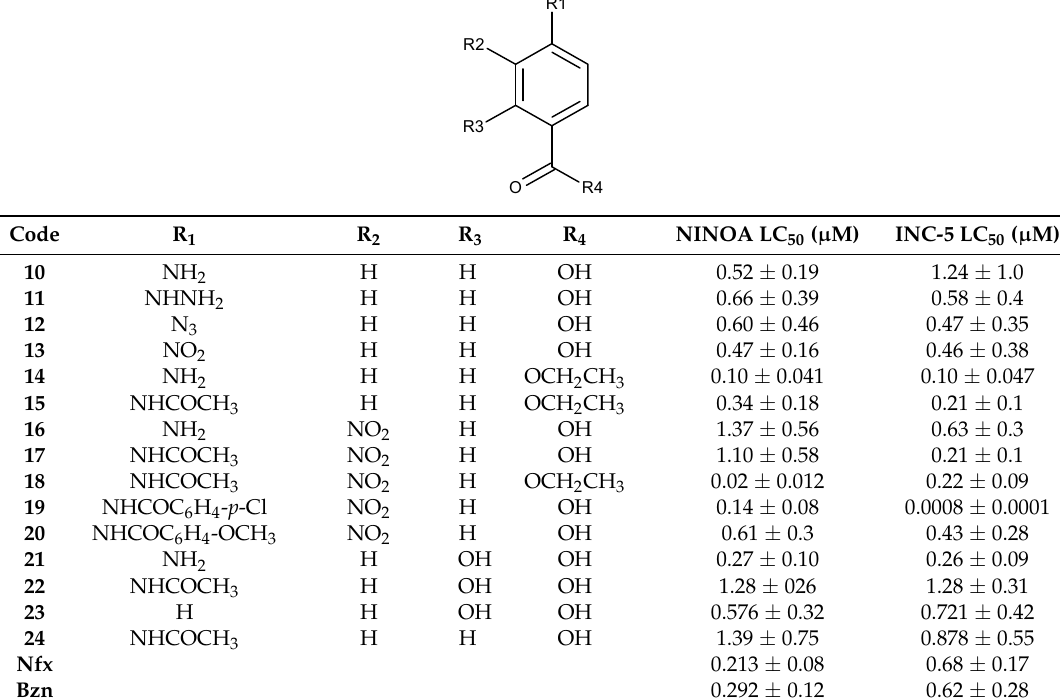
Table 1. Trypanocidal activity of benzoic acid derivatives on the NINOA and INC-5